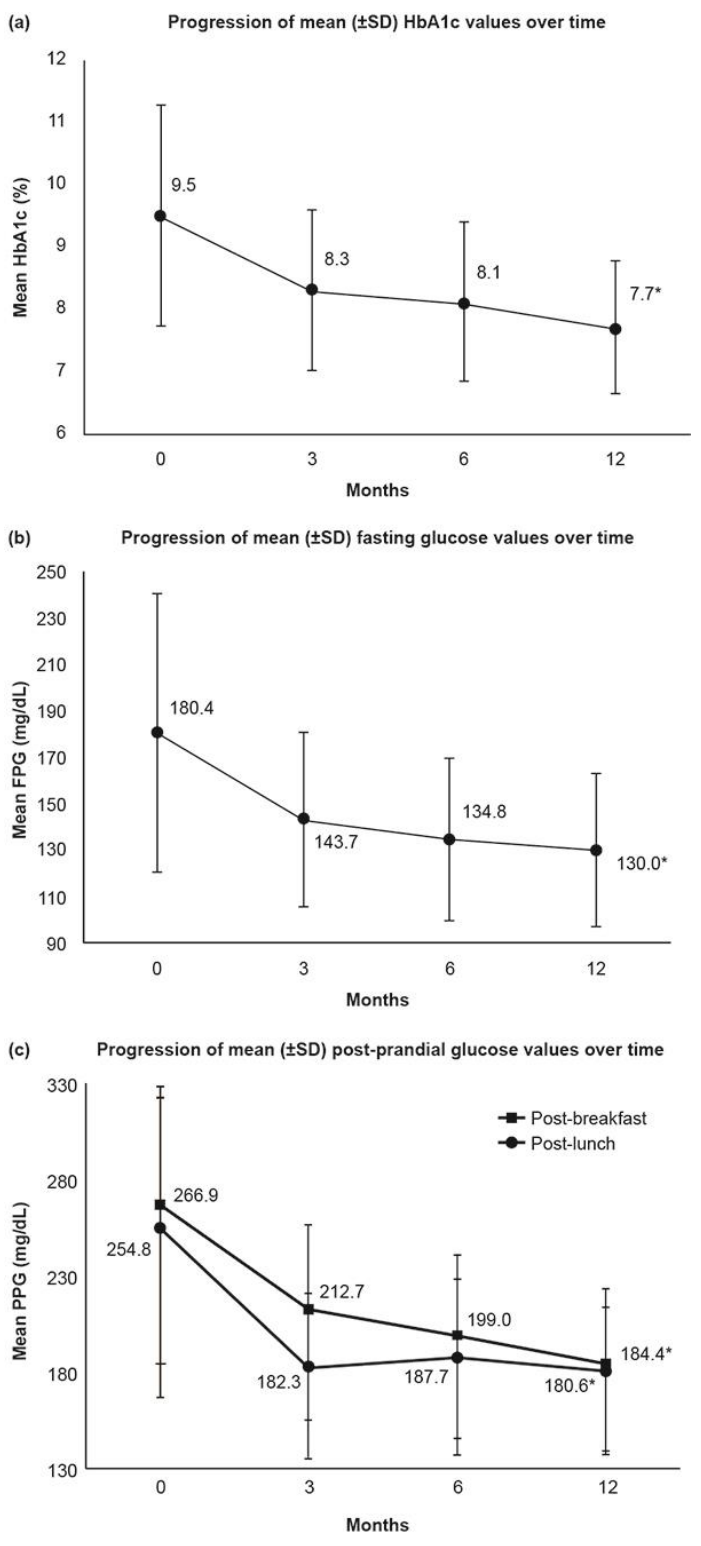
Figure 1. ( a ) Progression of mean ( ± SD) HbA1c values over time; ( b ) Progression of mean ( ± SD) fasting glucose values over time; ( c ) Progression of mean ( ± SD) post-prandial glucose values over time. FPG: Fasting plasma glucose; HbA1c: Glycosylated hemoglobin; PPG: Post-prandial plasma glucose; SD: Standard deviation. Note: All values are presented as mean ± SD. * ( p < 0.0001).